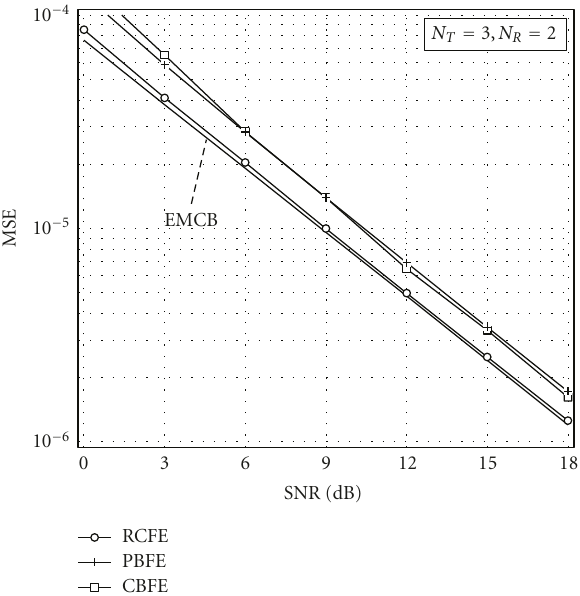
Figure 1: MSE of the FCFO estimators versus SNR with N T = 3 and N R =